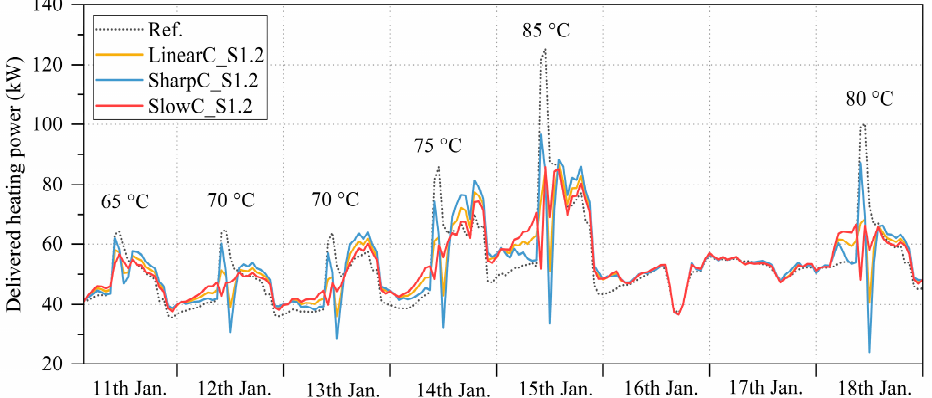
Figure 9. Delivered heating power with different control curves and maximum charging water temperature setpoints ( T set,max ) of a period in January.